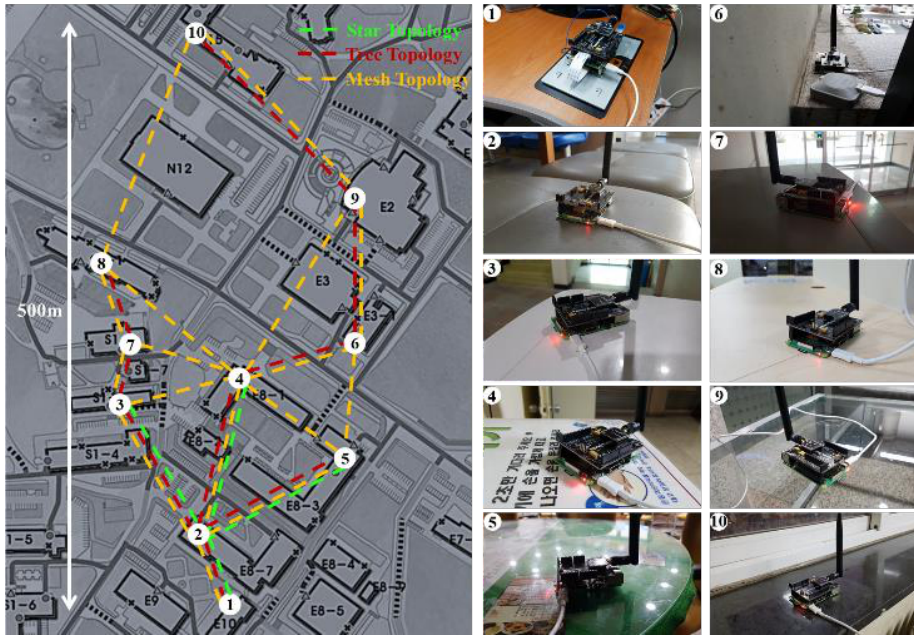
Figure 5. Experimental environments.